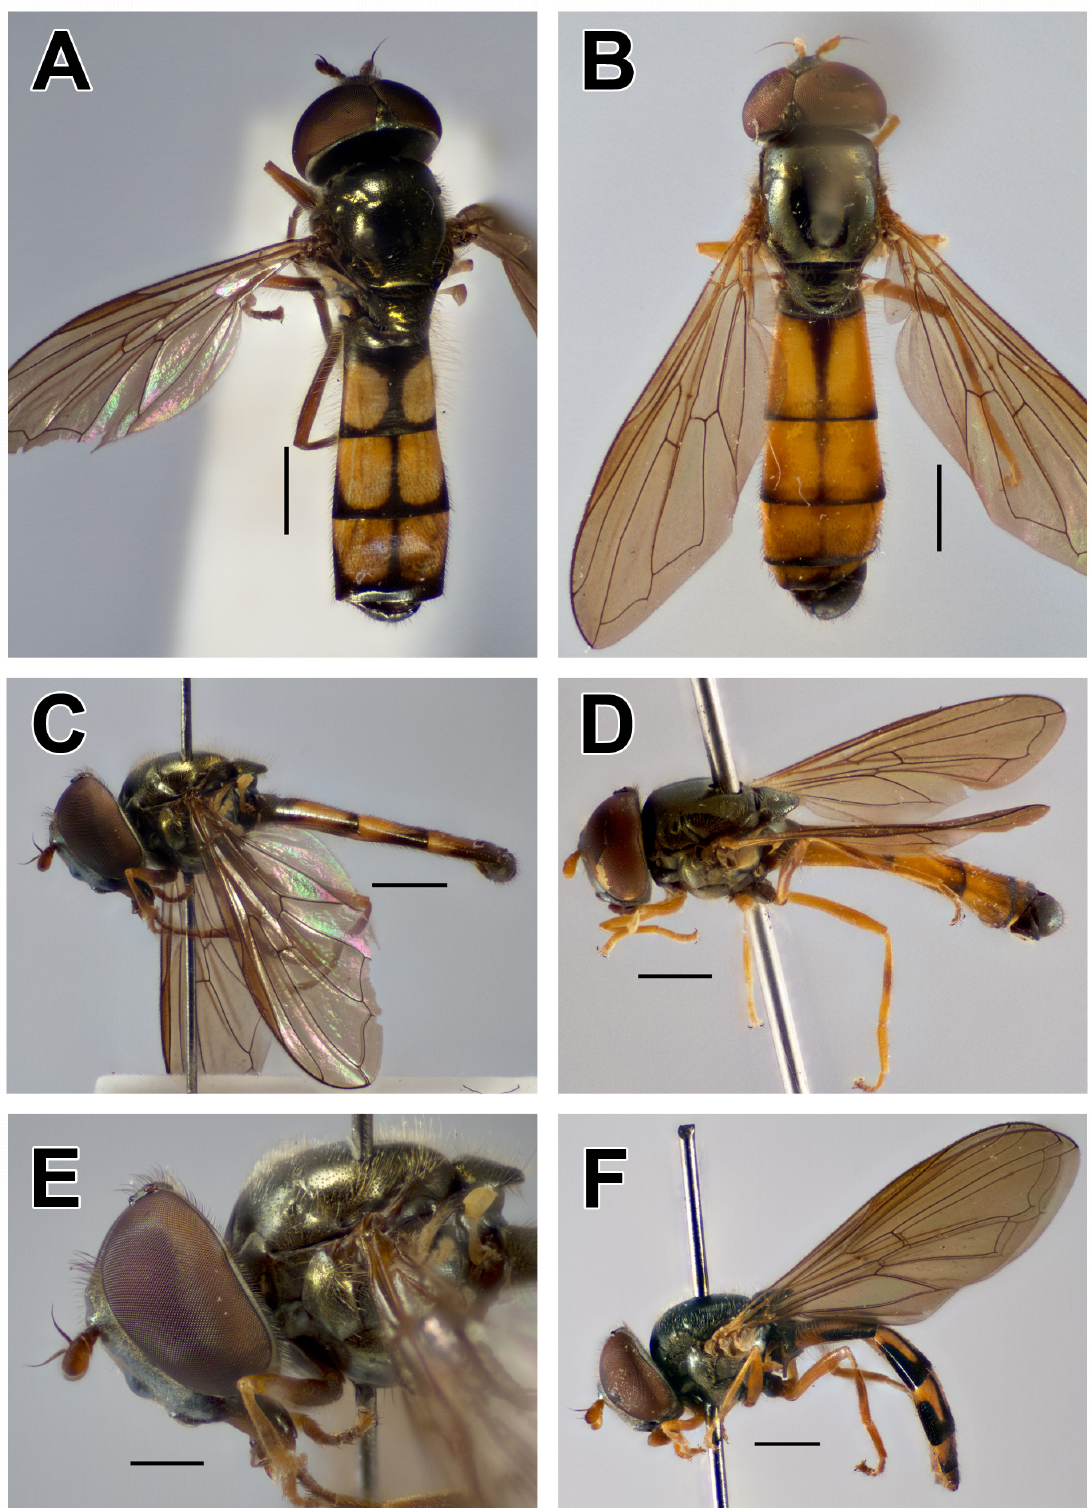
Fig. 7. A, C, E . Melanostoma fasciatum (Macquart, 1850), ♂ (AM_K407062). A. Dorsal view. C. Lateral view. E. Head and thorax, lateral view. B, D . Melanostoma univittatum (Wiedemann, 1824), ♂ (ZFMK-DIP-00019737). B. Dorsal view. D. Lateral view. F . Melanostoma apicale Bigot, 1884, ♀ (ZFMK-DIP-00019781), lateral view. Scale bars: A–D, F = 1 mm; E = 0.5